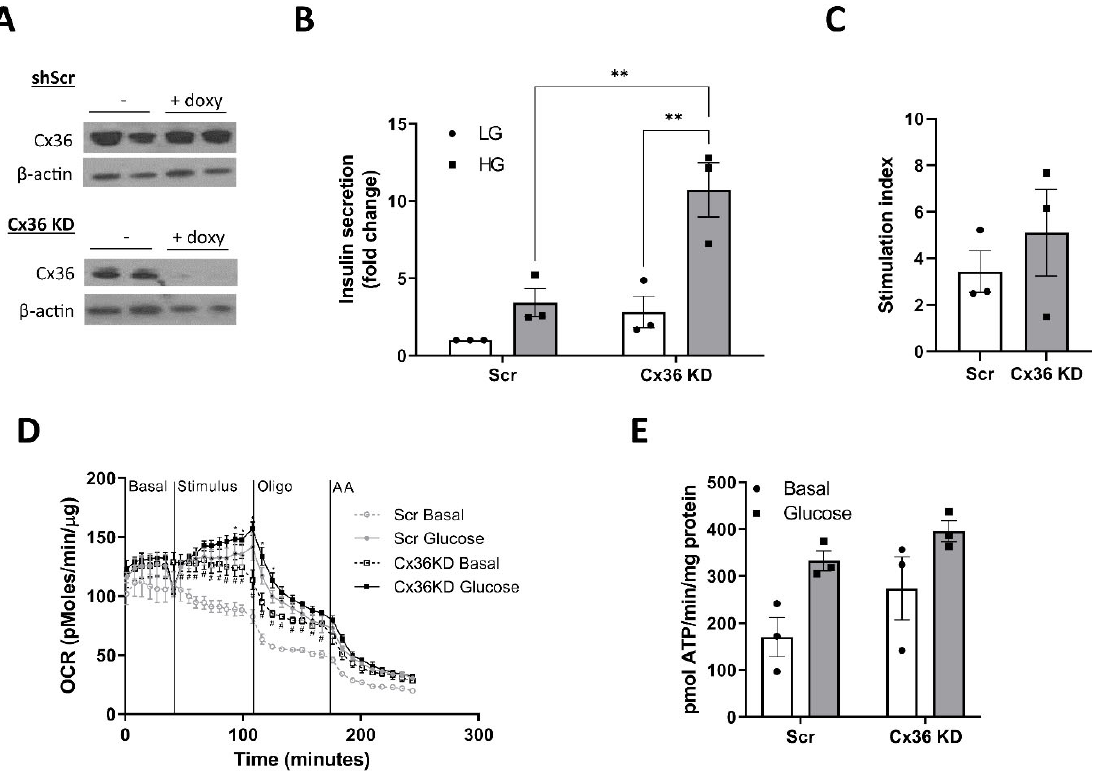
Figure 7. Connexin 36 does not significantly impact on GSIS or metabolic flux in pseudoislets. MIN6 cells expressing inducible scrambled shRNA (Scr) or shRNA against connexin 36 (Cx36 KD) were generated by transfection with lentiviral constructs followed by selection with 1 μ g/ml puromycin. Cells were cultured in un ‐ coated Petri dishes to generate PI for 3 days prior to the addition of 1